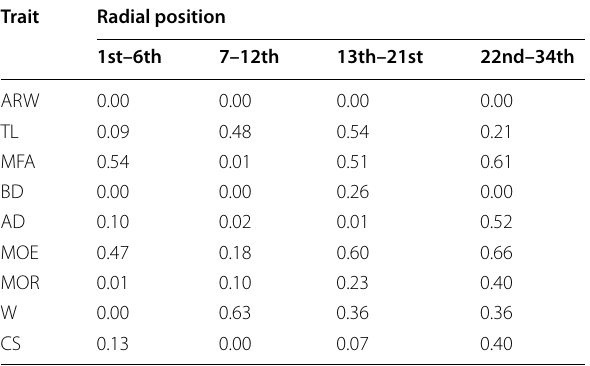
Table 8 Broad-sense heritability of all traits at each radial position